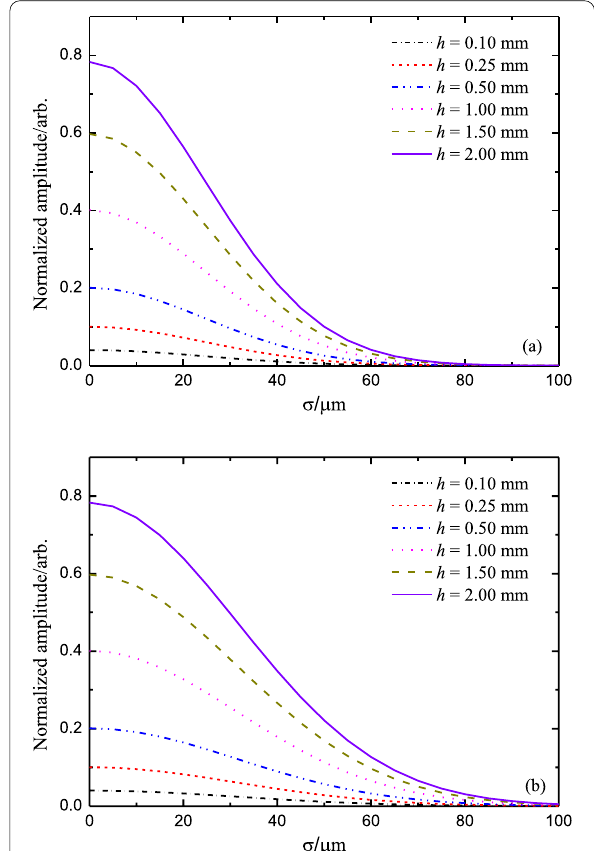
Figure 6 Predicted curve of echo amplitudes of cracks with different depths under a rough front surfaces and b rough back